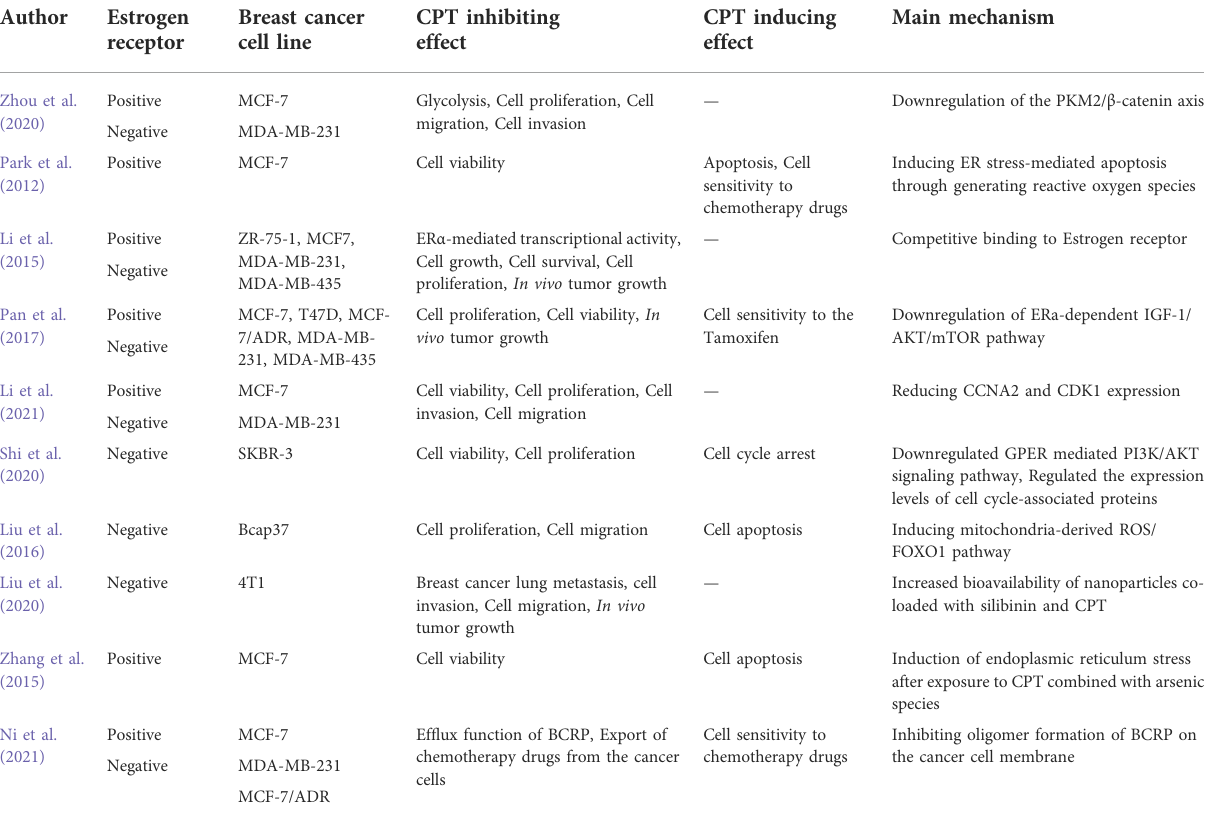
TABLE 1 The anti-breast cancer effects of CPT in estrogen-receptor dependent or independent